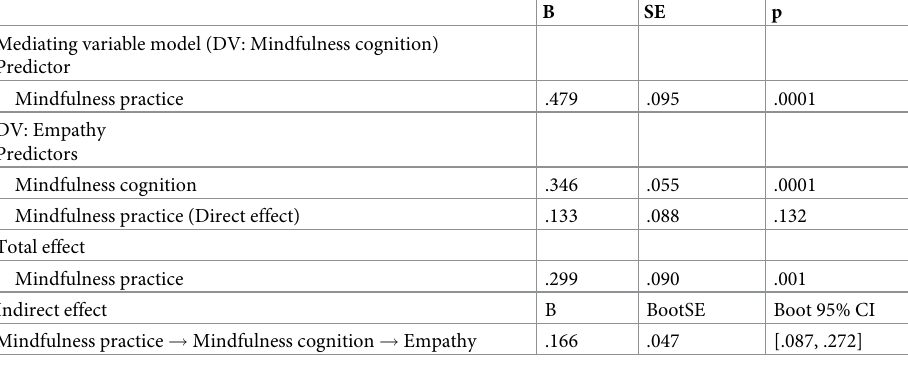
Table 1. Mediation model (PROCESS, Model 4): Indirect effect of mindfulness practice of (IV) on empathy (DV) through changes in mindfulness cognition (mediating variable). B SE